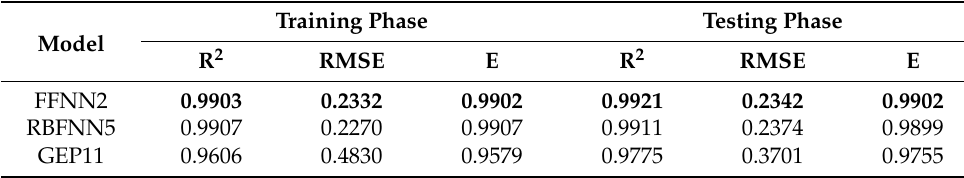
Table 8. Statistical criteria for the best combination of